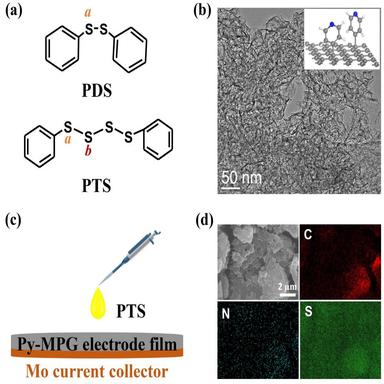
(a) Molecular structures of PDS and PTS. (b) TEM image of the Py-MPG host. (c) Schematic illustration of the accommodation of PTS in Py-MPG. (d) SEM image of the PTS/Py-MPG composite cathode and corresponding EDS maps of C, N, and S elements.